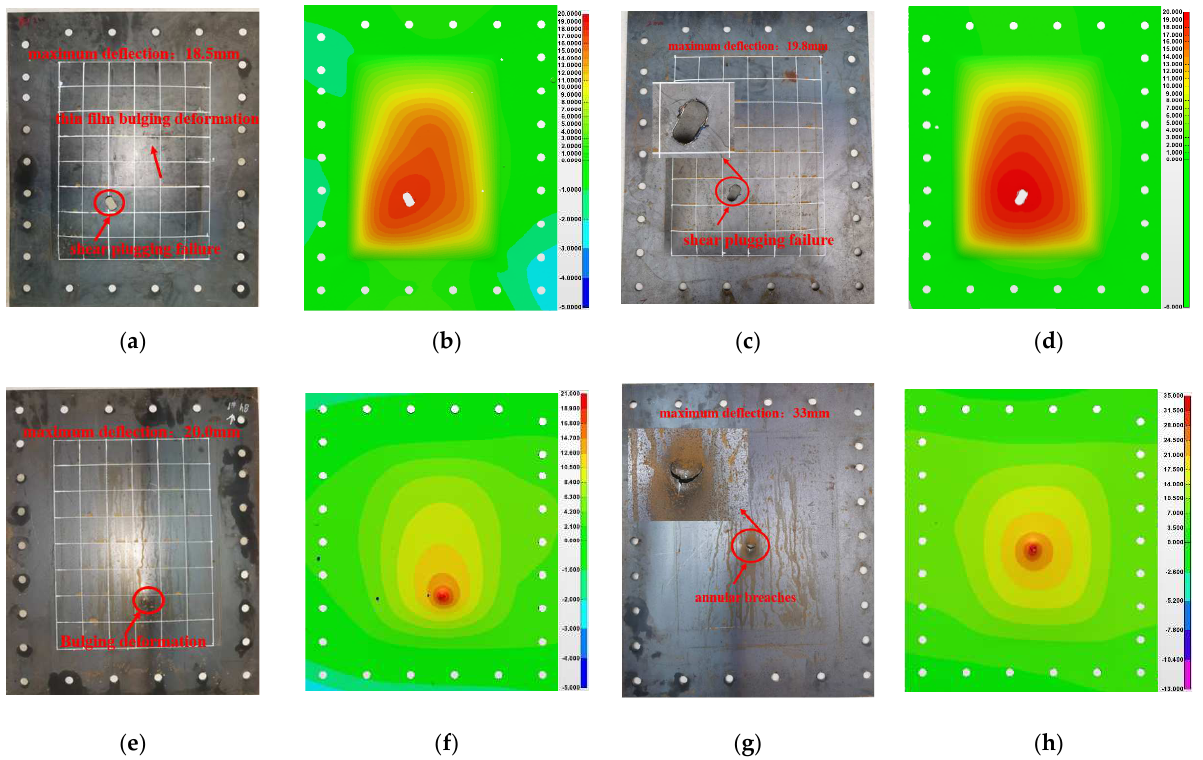
Figure 18. Deformation/failure diagram and deflection contour of the front and back plates. (the deflection unit: mm). ( a ) Deformation and failure diagram of the front plate in Test 1; ( b ) contour of deformation and deflection of the front plate in Test 1; ( c ) deformation and failure diagram of the front plate in Test 3; ( d ) contour of deformation and deflection of the front plate in Test 3; ( e ) deformation and failure diagram of the rear plate in Test 1; ( f ) contour of deformation and deflection of the rear plate in Test 1; ( g ) deformation and failure diagram of the rear plate in Test 3; ( h ) contour of deformation and deflection of the rear plate in No.